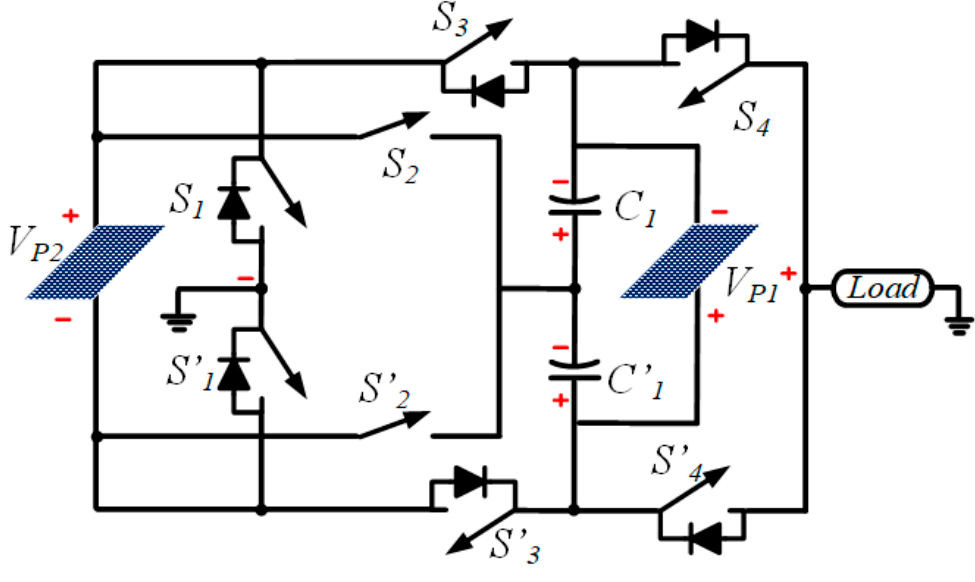
Figure 1. Circuit configuration of proposed module. Table 1. Switching scheme for 13-level generation.